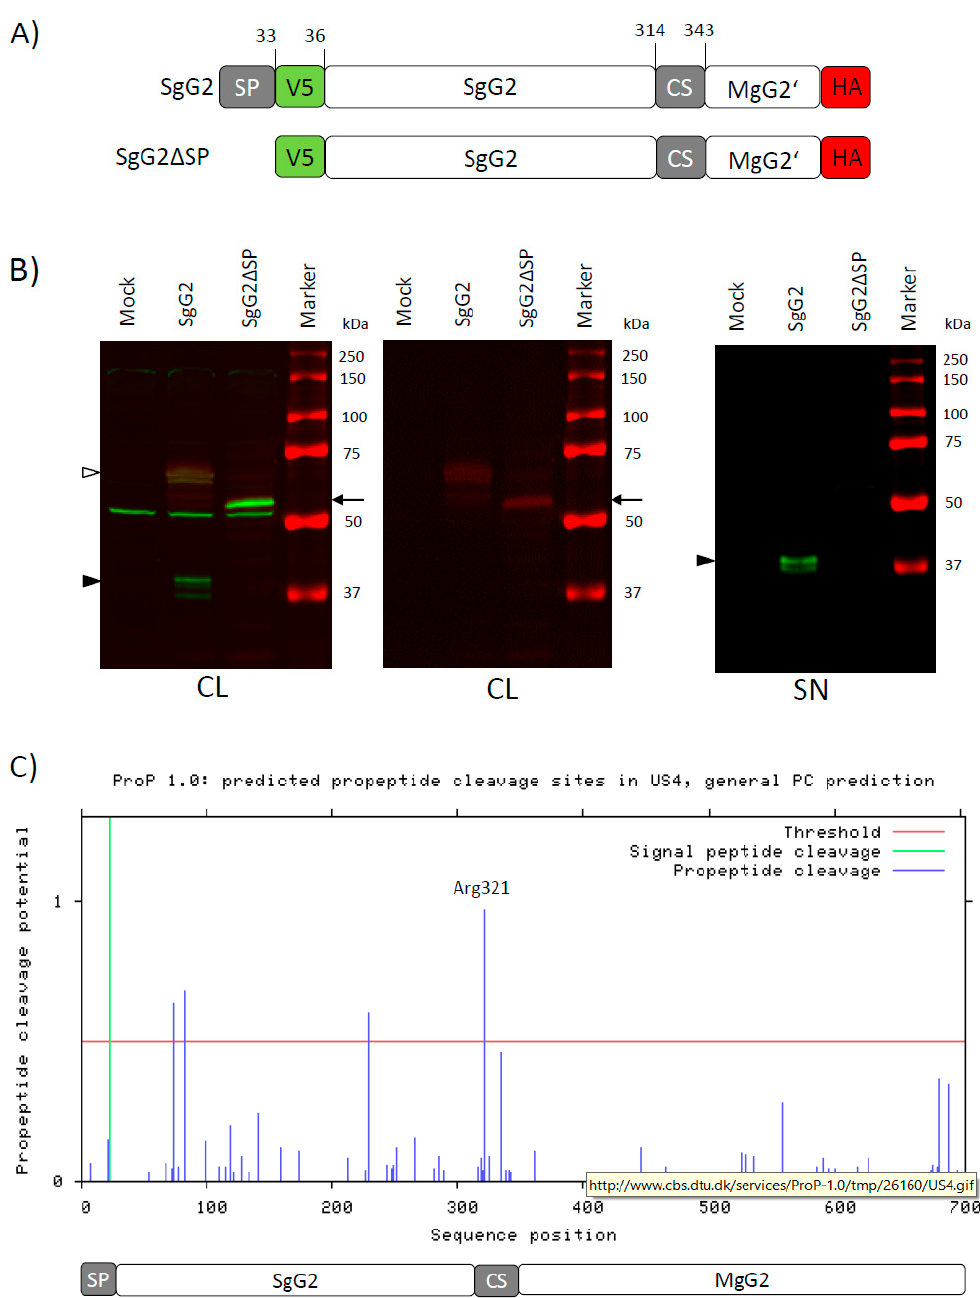
Figure 4. Correct sorting is necessary for cleavage of gG2. ( A ) Schematic representation of the SgG2 and the SgG2 ∆ SP constructs. Indicated amino acid positions are based on HSV-2 strain 333 gG2 WT sequence. ( B ) Western blots showing detection of gG2 proteins in the cell lysate (CL, left and middle blot) and supernatant (SN, right blot) of HEK-293T cells transfected with SgG2 or SgG2 ∆ SP. The left panel shows green and red channel in composite image, the middle blot shows only the HA-tag signal in the red channel for the cell lysate samples. The proteins were detected with anti-V5 ( green ) and anti-HA ( red ) antibodies. Black arrowheads indicate position of SgG2 cleavage products, white arrowhead indicates precursor proteins. Black arrow indicates unprocessed product of SgG2 ∆ SP. One of three independent experiments is shown. ( C ) Bioinformatics online tool ProP 1.0 [25] was used to analyse the sequence of gG2 for general propeptide convertase (PC) cleavage motifs. Schematic representation of gG2 domains in relation to detected motifs. Motif with the highest score at Arg321 is indicated. Indicated amino acid positions are based on HSV-2 strain 333 gG2 WT sequence.